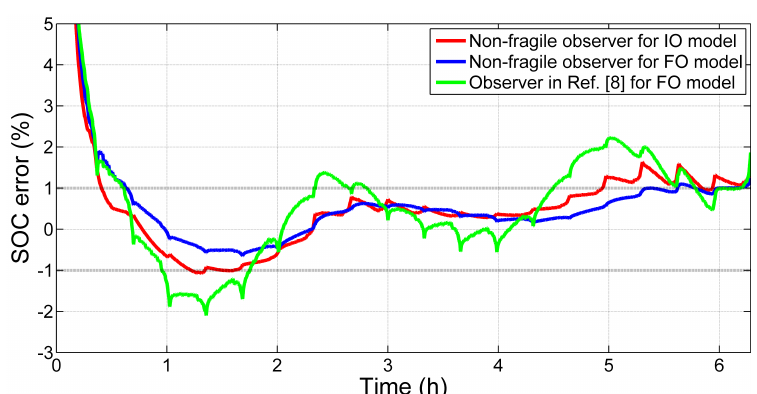
Figure 11. SOC estimation error profiles for